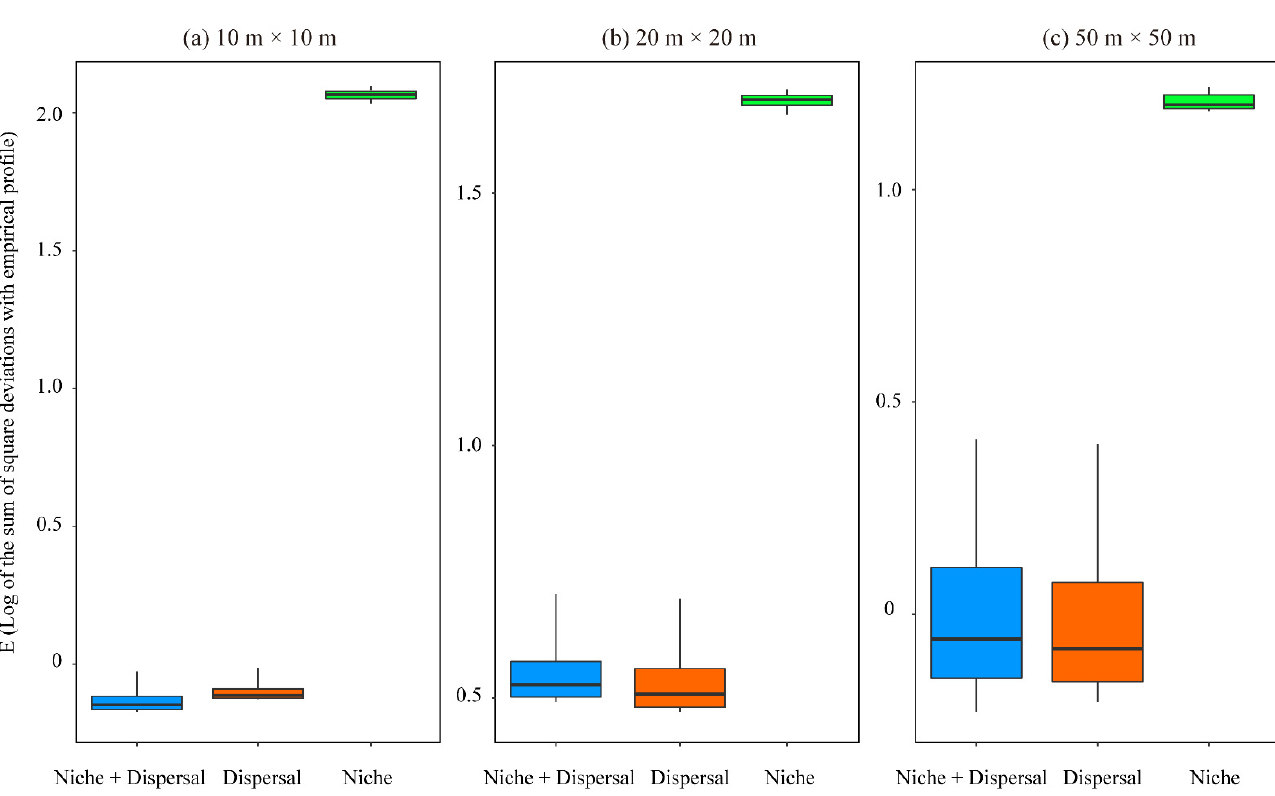
Figure 2. Example of E-metric distributions resulting from the permutational SIMPER analyses for the different plot sizes of ( a ) 10 m × 10 m, ( b ) 20 m × 20 m, and ( c ) 50 m × 50 m. The blue boxplot represents niche-based and dispersal-based controlled distribution. The orange boxplot represents dispersal-based controlled distribution. The green boxplot represents niche-based controlled distribution.